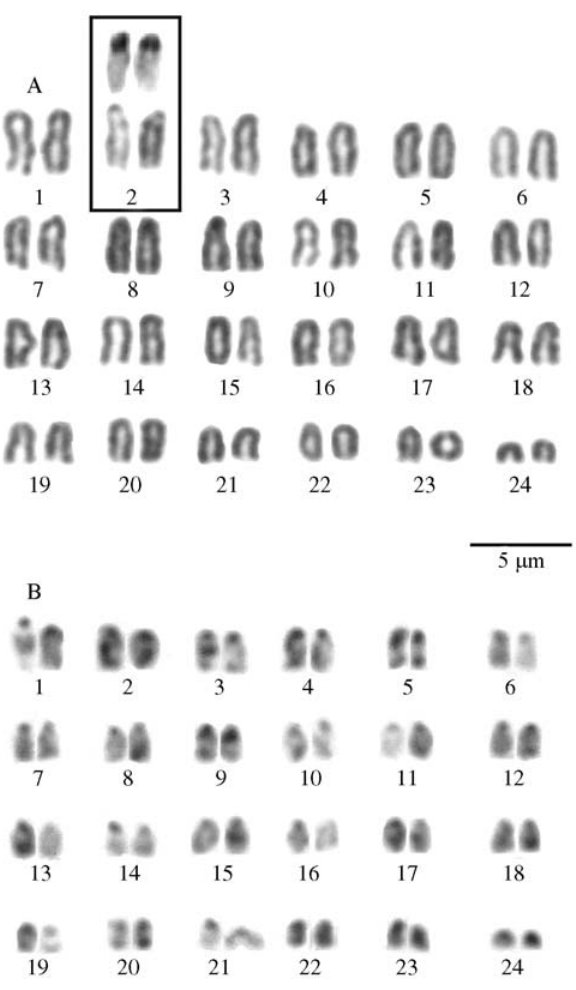
Figure 5 - Karyotype of Lutjanus synagris . (A) Conventional Giemsa staining. In detail, the secondary constrictions equivalent to NORs. (B) C-banding in Lutjanus synagris